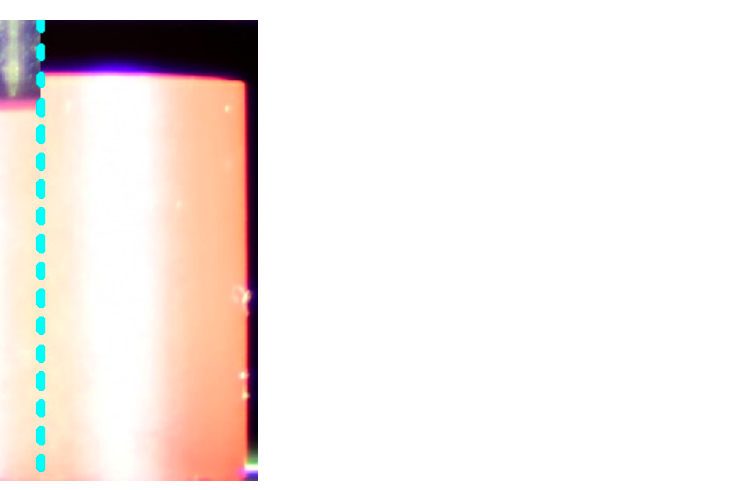
Figure 7. Compressed sample ( left side), uncompressed sample ( right side). Sample dimensions r = 5 mm; h = 10 mm; sample quantity during test: 4.